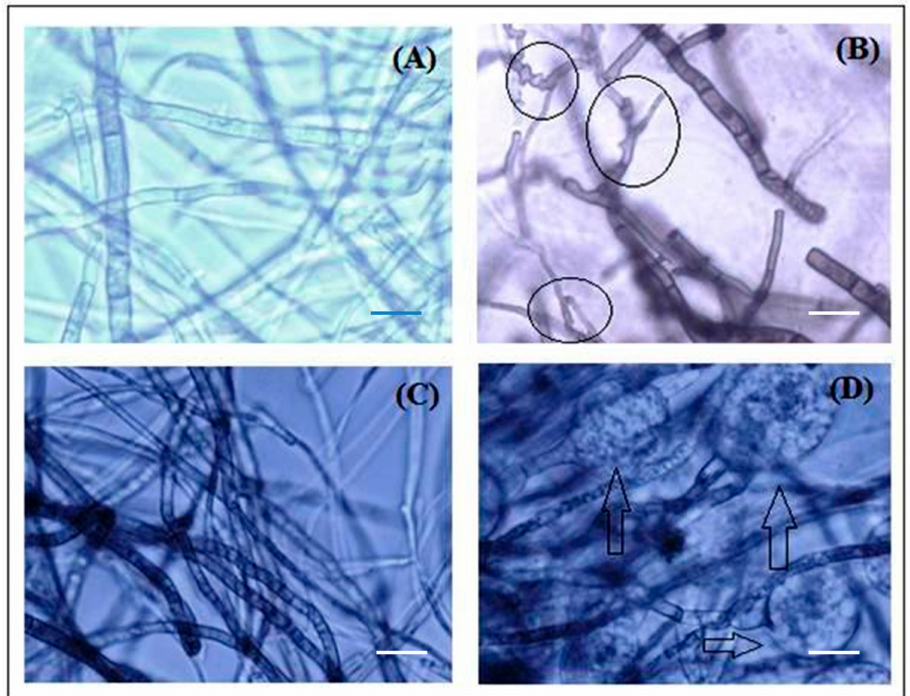
Figure 7. Impact of biosynthesized zinc nanoparticles on the morphology of fungi before and after treatment observed in the light microscope with 40 × magnification. ( A ), ( B ) is Diplodia seriata and ( C ), ( D ) is Botryosphaeria dothide; While as, ( A ), ( C ) shows untreated fungi, ( B ), ( D ) shows cytoplasmic aberration caused by zinc nanoparticles. Bar scale—5 µ